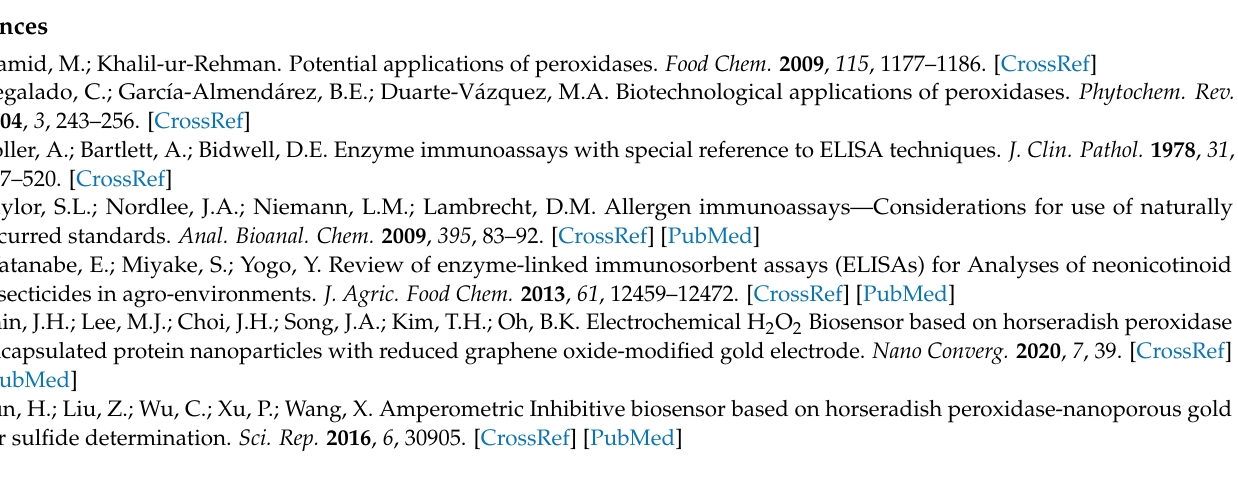
Ratios of each component and chemical bonds in N-CDs and Mn:N-CDs, Figure S4: Lineweaver– Burk plot for the kinetic analysis of N-CDs and Mn:N-CDs, Figure S5: Viability test of N-CDs and Mn:N-CDs, Figure S6: The image of reaction solution containing TMB, H 2 O 2 , and Mn:N-CDs under different pH, Figure S7: Image of reaction solutions that were mixed with citric acid, L-aspartic acid, and L-glutamic acid, respectively, Figure S8: Image of reaction solutions containing TMB, H 2 O 2 , and Mn:N-CDs, that are mixed with GABA containing buffer or artificial urine, individually, Figure S9: Variation in absorption (at 652 nm) of the mixed solution containing Mn:N-CDs, GABA, TMB, and H 2 O 2 as a function of the concentration of GABA, Figure S10: Calculation of limit of detection (LOD) and quantitation